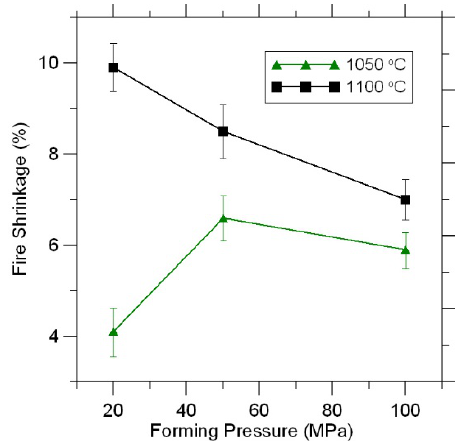
Figure 7. Fire shrinkage versus forming pressure at different firing temperatures.